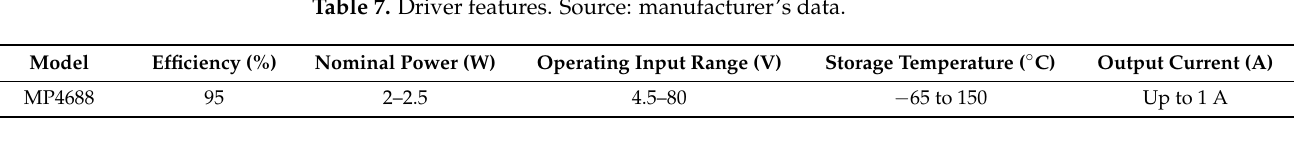
Table 7. Driver features. Source: manufacturer’s